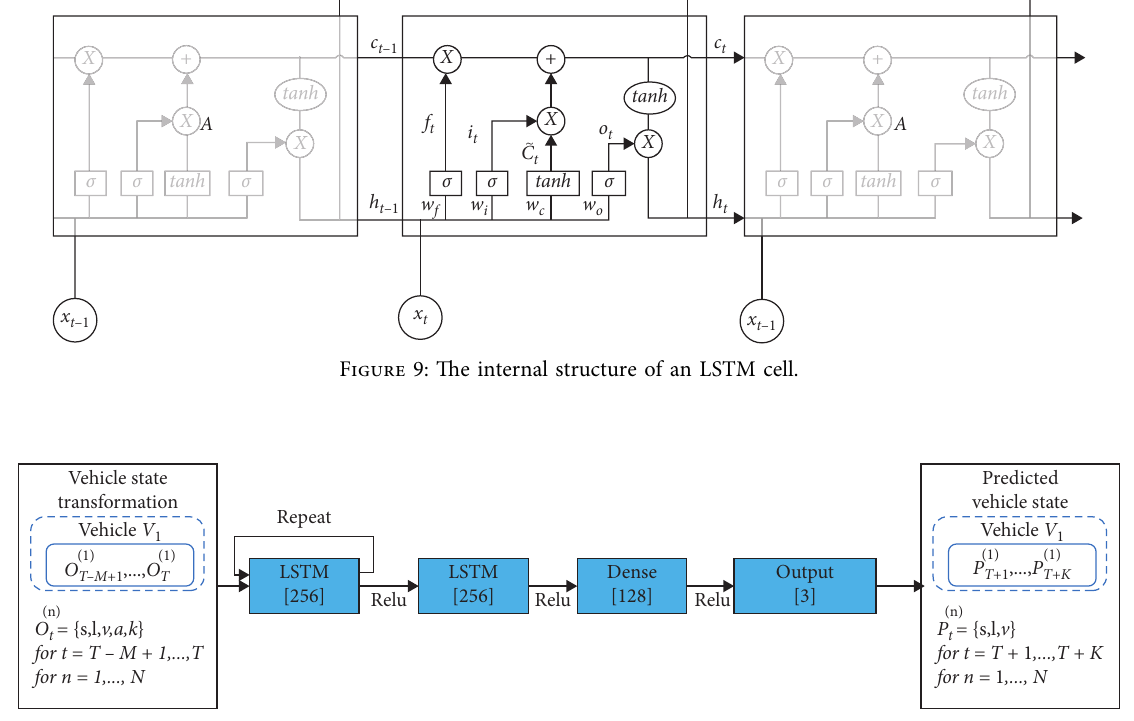
Figure 10: Network structure used as a reference